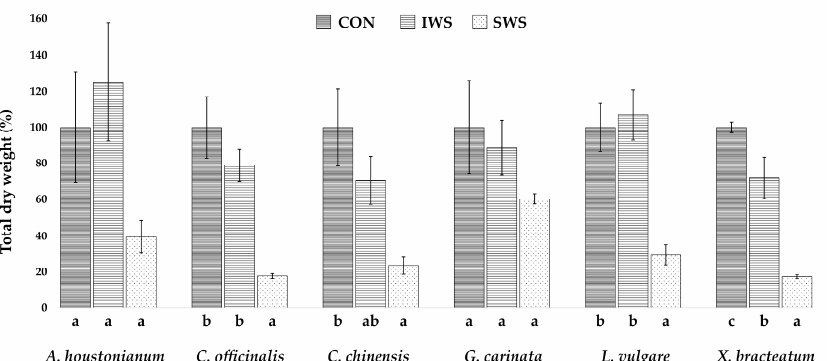
Figure 5. Effect of water stress on the total dry weight in the six Asteraceae species. Bars indicate mean values with SE ( n = 5) of percentage relative to the control averages for each species, shown in Table 1. Different lowercase letters indicate significant differences between treatments (CON—control, IWS—intermediate water stress, and SWS—severe water stress) per species, according to the Tukey test ( p < 0.05).